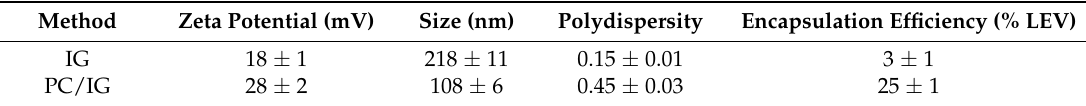
Table 3. Characterization of chitosan (CS) nanoparticles obtained by using ionic gelation (IG), and PC/IG methods (experimental results are expressed as the mean ± SD, n = 6 for DSL measurements and n = 3 for